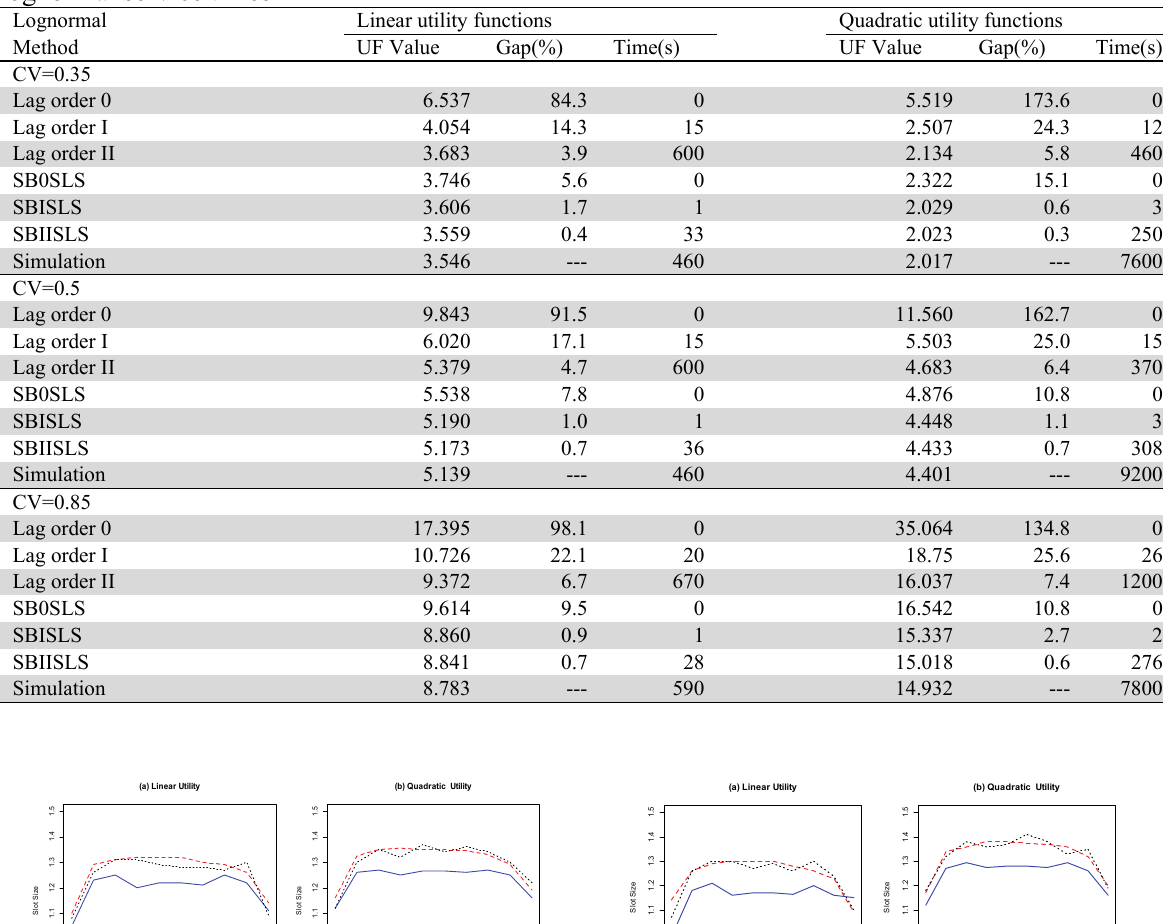
Optimization results of SBKSLS compared with lag order method and simulation. (cid:1840) (cid:3404) 11 , i.i.d.